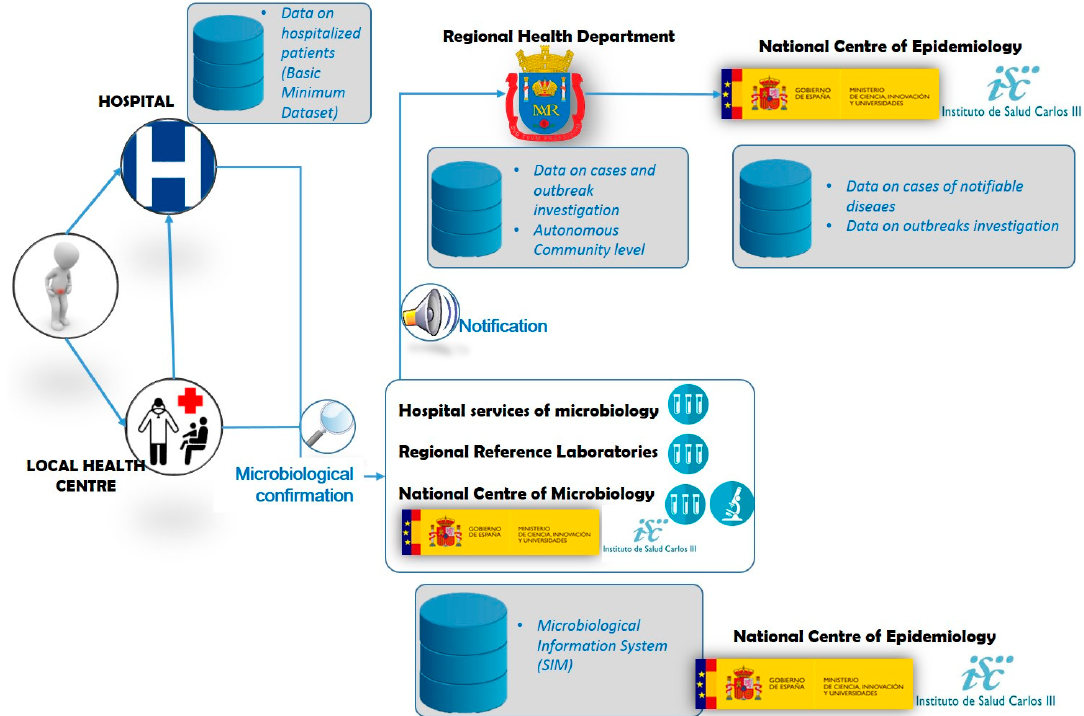
Figure 4. Salmonella surveillance in suspect patients in Spain (from ingestion of contaminated product or other exposure route). It summarizes the surveillance of Salmonella in humans, which starts with the onset of clinical signs in a suspect patient.